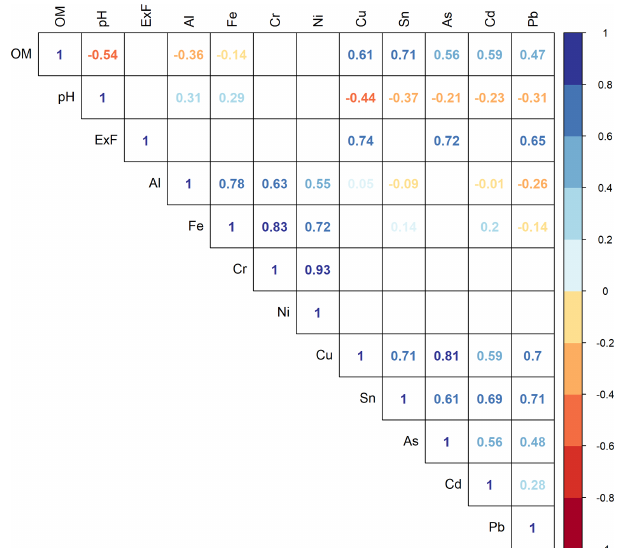
Figure 4. Spearman correlation matrix for organic matter (OM), pH, exposure factor (ExF) and elemental concentrations in pave- ment joints. Spearman’s ρ is displayed in the grid if the correlation is significant ( p value < 0 . 05). Positive correlations in blues; nega- tive correlations in